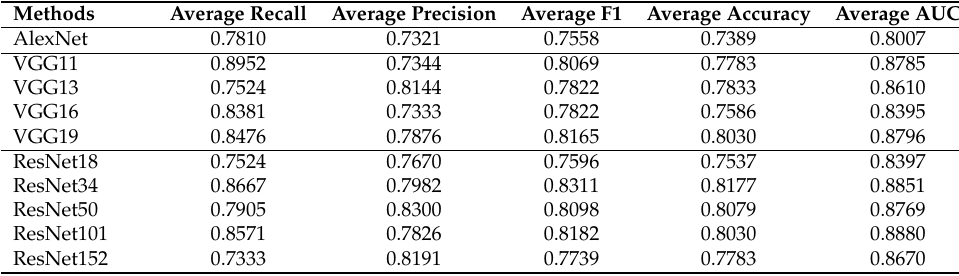
Table 1. Five quantitative measures for state-of-the-art deep learning networks on COVIDCT. The vari- ants of the same algorithm are differentiated via the number at the end of the method’s name.